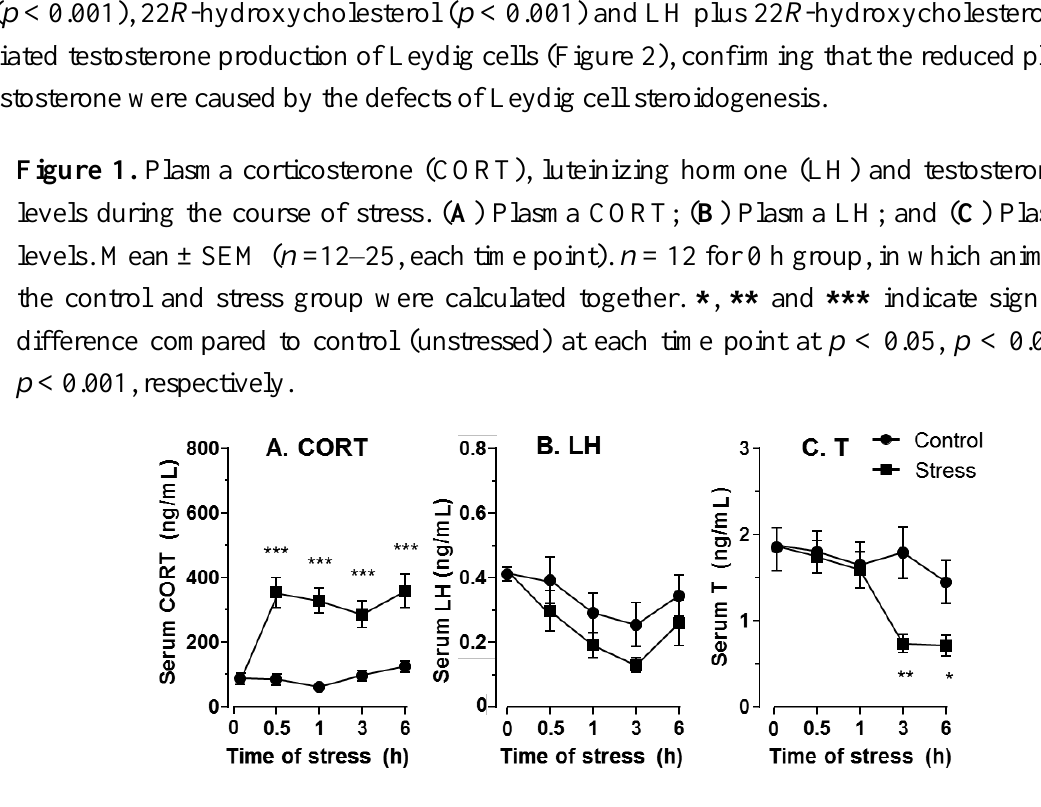
Figure 2. Testosterone production by rat Leydig cells from control (CON, unstressed) and stress rats. Leydig cells were stimulated for 3 h without (basal) or with 100 ng/mL LH (LH) or 20 µM 22 R -hydroxycholesterol (22 R ) or both (LH + 22 R ). ( A ) Basal; ( B ) LH; ( C ) 22 R ; and ( D ) LH + 22 R . Mean ± SEM ( n = 14–16). * , *** indicate significant differences compared to the control at p < 0.05 and p < 0.001,